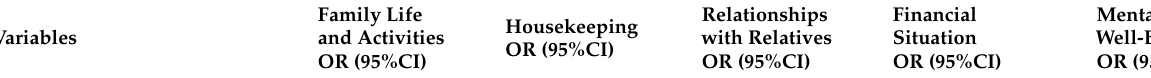
Table 3. The association of pandemic management with the quality of life of dentists; results of logistic regression analyses adjusted for age and gender leading to odds ratios, OR, and 95% confidence intervals